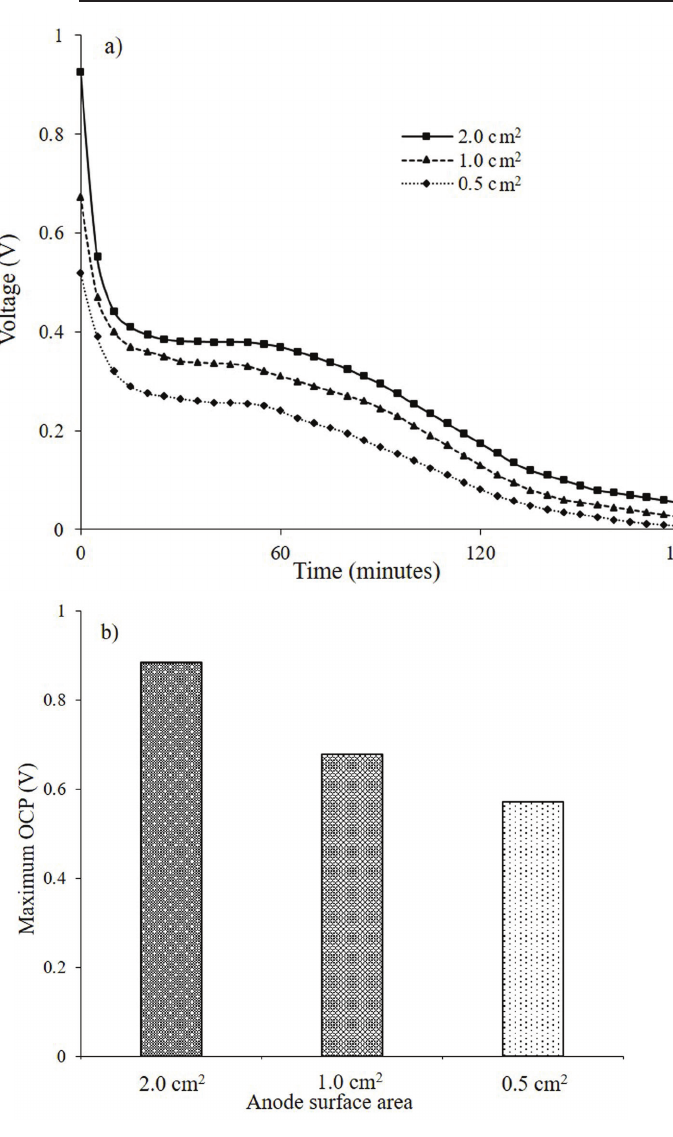
Fig. 7 – Effect of anode surface area on the voltage output (a), and the open-circuit potential (b) of the CW-MFC